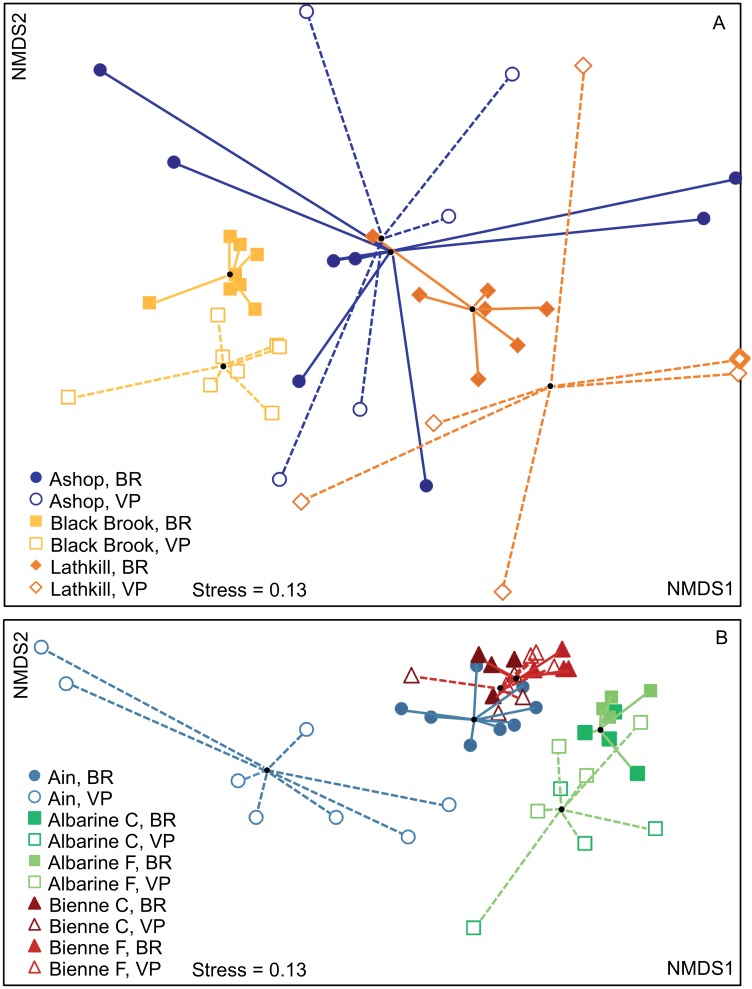
Non-metric multidimensional scaling ordination of macroinvertebrate assemblage composition characterized by two hyporheic pump-sampling techniques in three streams in: (A) the UK; (B) France.The two techniques are Bou-Rouch (BR) and vacuum-pump (VP) sampling. Albarine and Bienne samples are separated into coarse-grained (C) and fine-grained (F) sites due to differences in assemblage composition. Lines link individual samples to the stream/site-technique group centroid. N = 8 for Ain, Black Brook and Ashop BR; n = 7 for Lathkill BR; n = 6 for Lathkill VP; and n = 5 for Ashop VP stream-technique groups (other samples contained no macroinvertebrates); n = 4 for Albarine and Bienne site-technique groups. The high NMDS1 score of a Lathkill VP sample (indicated by a thick border) was reduced from 3.1 to aid presentation.